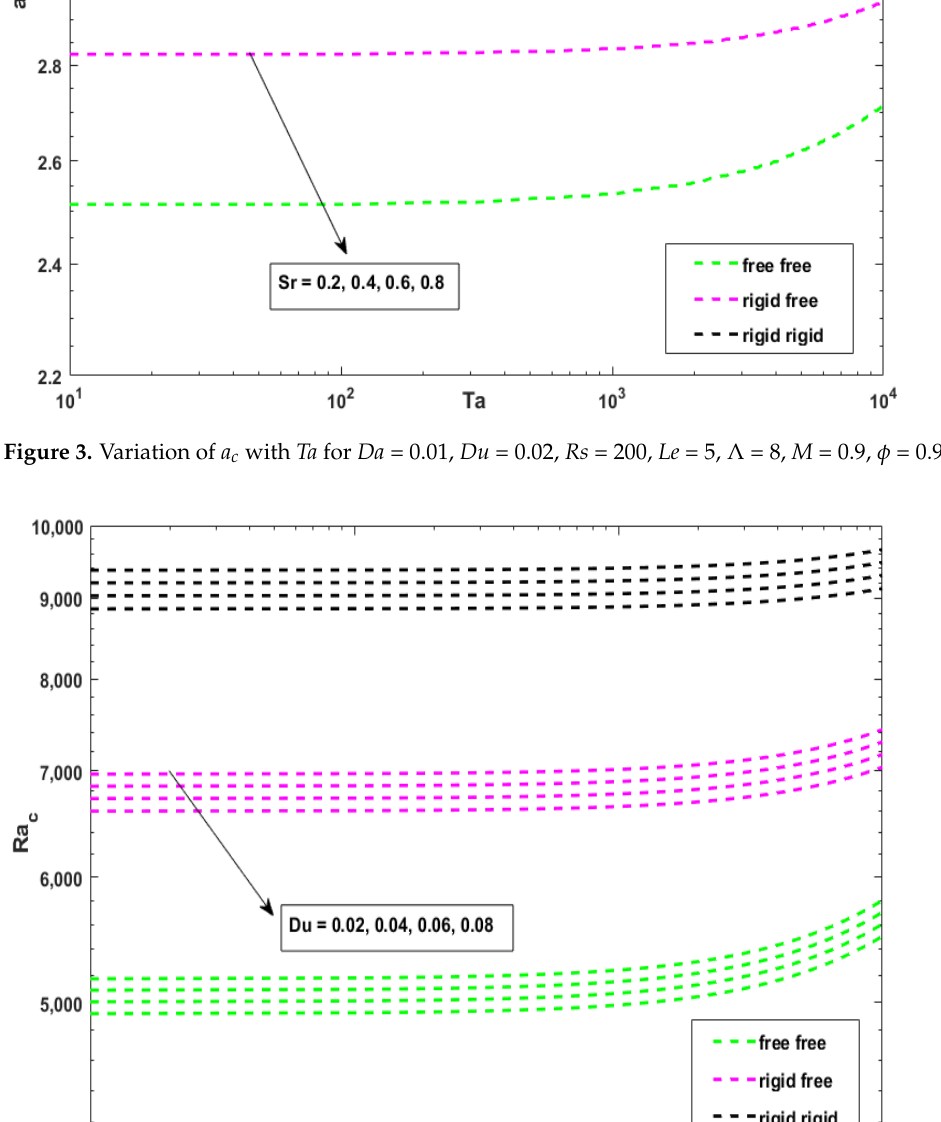
Figure 4. Variation of Ra c with Ta for Da = 0.01, Sr = 0.2, Rs = 200, Le = 5, Λ = 8, M = 0.9, ϕ = 0.9.